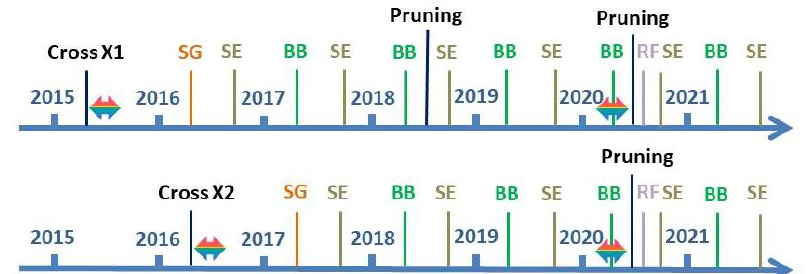
Figure 1. Timelines indicating the controlled crossings X1 and X2, the temperature treatments during the seed maturation (horizontal two-pointed arrow), seed germination, the phenological observations on the plants, the pruning of the plants, and the temperature treatment in 2020 (horizontal two-pointed arrow). SG: seed germination (orange lines); SE: leaf senescence (brown-green lines); BB: bud burst (green lines); RF: reflushing of dormant buds (light purple lines).